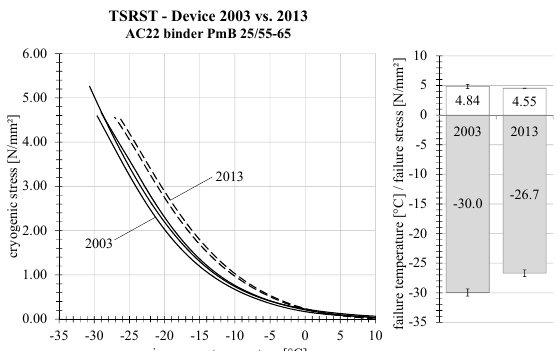
Figure 1. Example of TSRST results from 2003 (left bar) and 2013 (right bar) device.